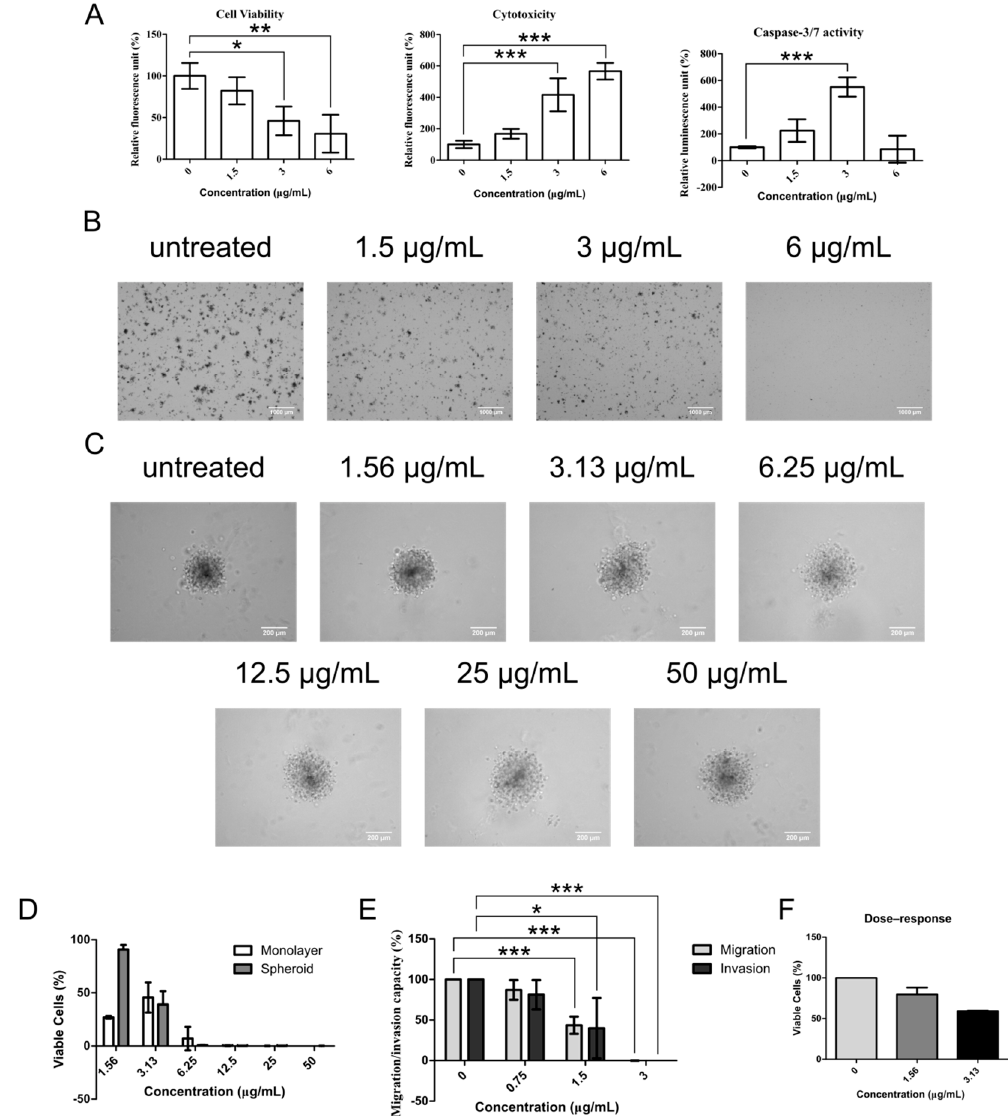
Figure 3. Chelerythrine chloride induces apoptosis and inhibits CSC functions. ( A ) Parallel estimations of cell viability, cytotoxicity and apoptosis were performed after 24 h treatment of chelerythrine chloride in NCI-H1703 at indicated concentrations using ApoTox-Glo triplex assay. ( B ) Representative micrographs show three weeks grown soft agar colonies of NCI-H1703 upon treatment of chelerythrine chloride at indicated concentrations. Scale bars represent 1000 µ m. ( C ) Representative micrographs show spheroids’ morphological characteristics after 24 h treatment of chelerythrine chloride at indicated concentrations. Scale bars represent 200 µ m. ( D ) Dose–response bar graph show comparison of cytotoxicity of various concentration of chelerythrine chloride between monolayer and spheroid models of NCI-H1703. ( E ) Estimations of migration and invasion of NCI-H1703 after 16 h of chelerythrine chloride treatment at indicated concentrations using real-time cell analyzer (RTCA). ( F ) E ff ect of corresponding treatment concentrations in ( E ) to cell viability is shown in bar graph. All data were obtained from mean of three independent experiments. Error bars are expressed as mean ± SD. Statistical significance was expressed as *** p < 0.001 ** p < 0.01; * p < 0.05.